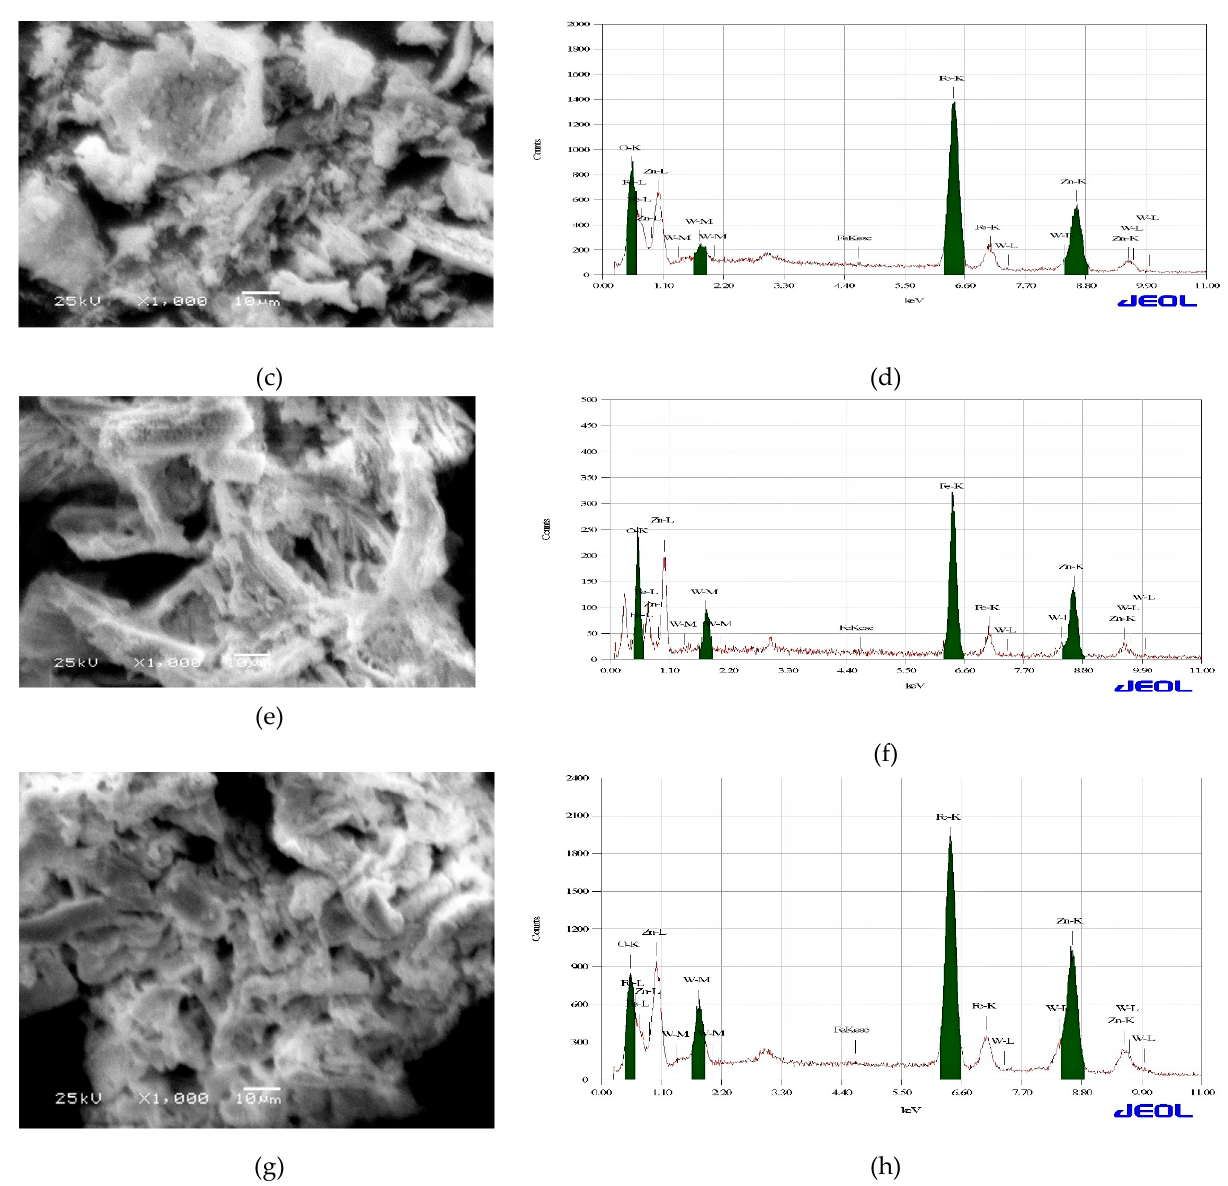
Figure 2. SEM and EDS micrographs of ( a , b ) ZnFe 2 O 4 , ( c , d ) ZnW 0.05 Fe 1.95 O 4 , ( e , f ) ZnW 0.1 Fe 1.90 O 4 , and ( g , h ) ZnW 0.15 Fe 1.85 O 4 .